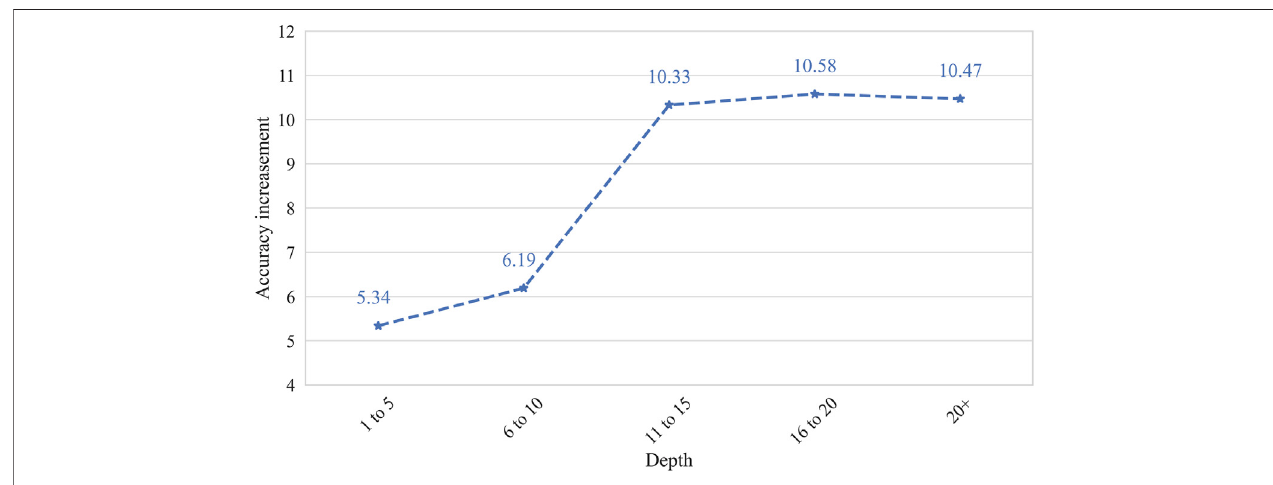
FIGURE 5 | The accuracy increasement of twitter post with various number of responses.